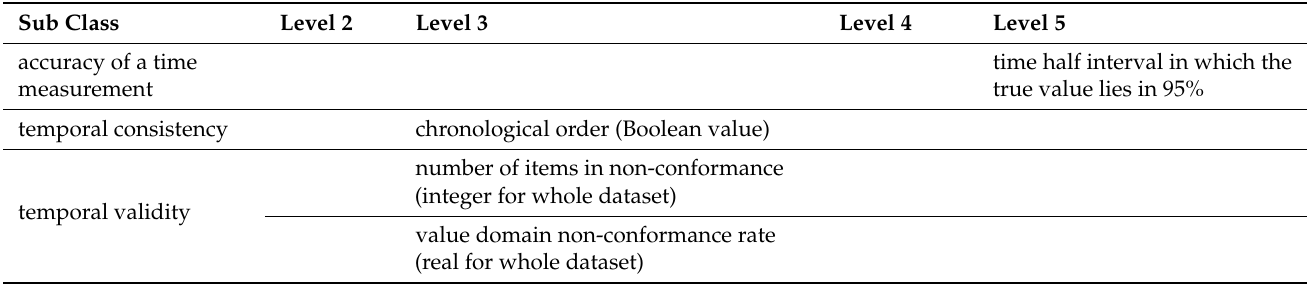
Table A5. Spatial data quality matrix for class temporal quality.